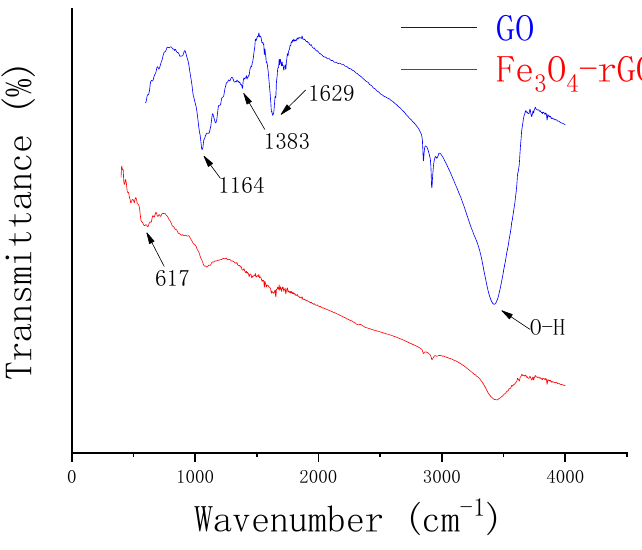
Figure 4. FTIR results of GO and Fe 3 O 4